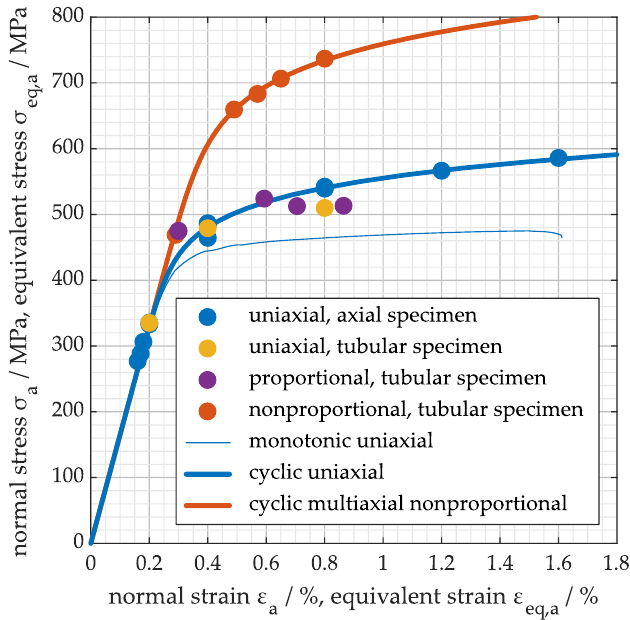
Figure 13. Comparison of results for uniaxial monotonic and cyclic deformation behavior with uniaxial, proportional, and nonproportional loading.